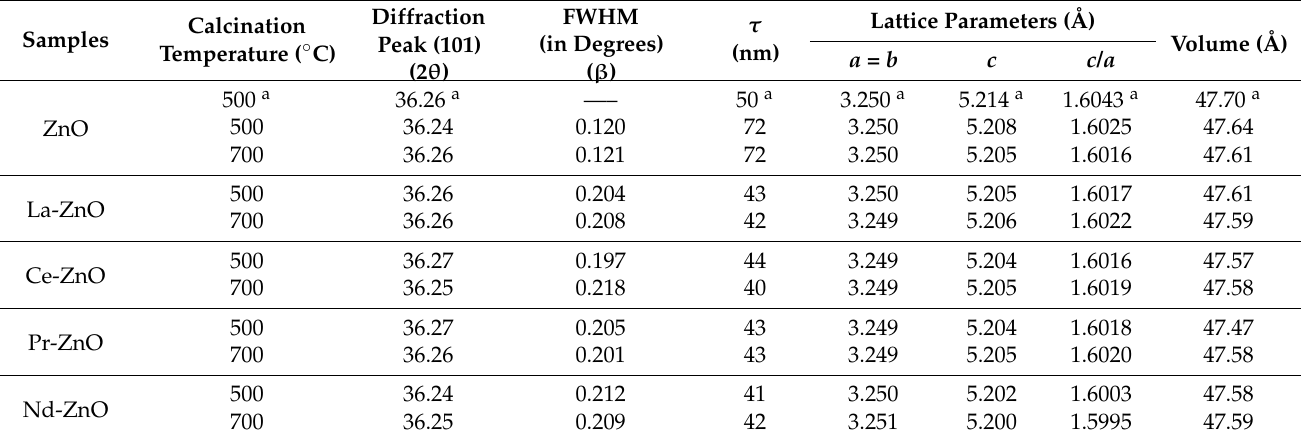
Table 2. Average crystallite size ( τ ), lattice parameters and unit cell volume of the ZnO and M-ZnO (M = La 3+ , Ce 3+ , Pr 3+ and Nd 3+ ) nanoparticles calcined to 500 ◦ C and 700 ◦ C.